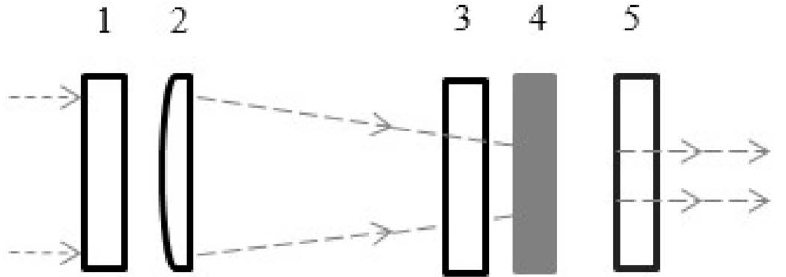
Figure 4. Optical scheme of the Ti:Sapphire laser. Here, 1 is microlens array homogenizer; 2 is the condenser lens; 3 and 5 are pump and output mirrors, respectively; and 4 is the Ti:Sapphire active crystal. Reprinted with permission from ref. [17]. Copyright 2019 © The Optical